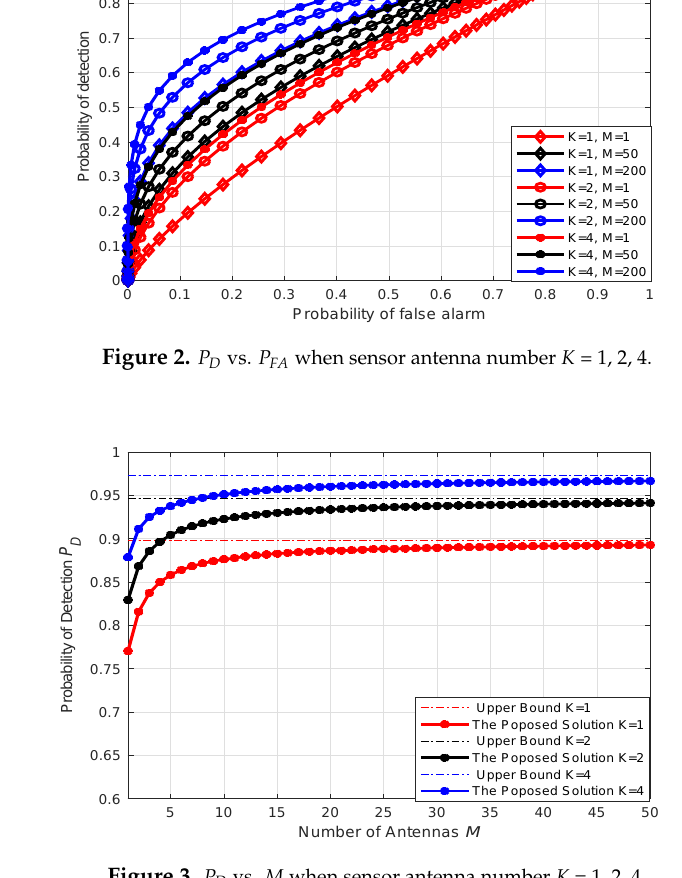
Figure 3. P D vs. M when sensor antenna number K = 1, 2,